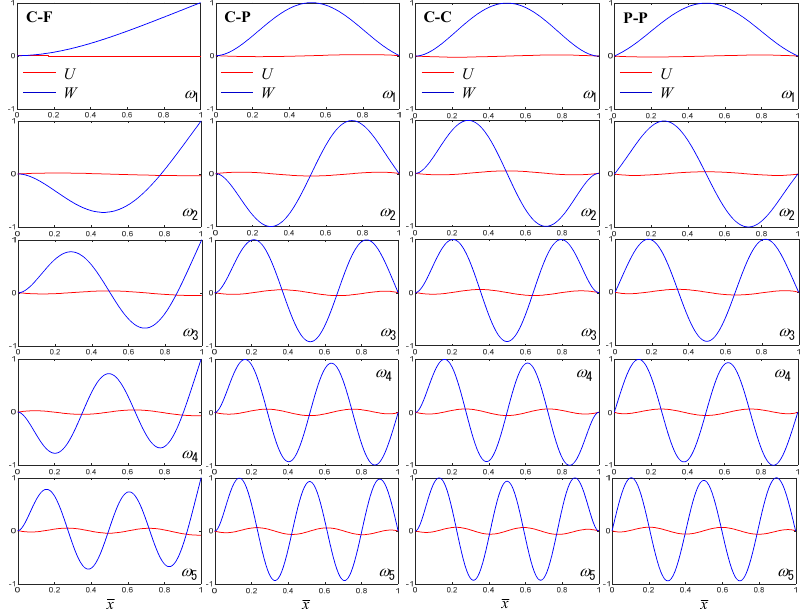
Figure 2. First five mode shapes of the symmetric three-layered beam with four classical end conditions.